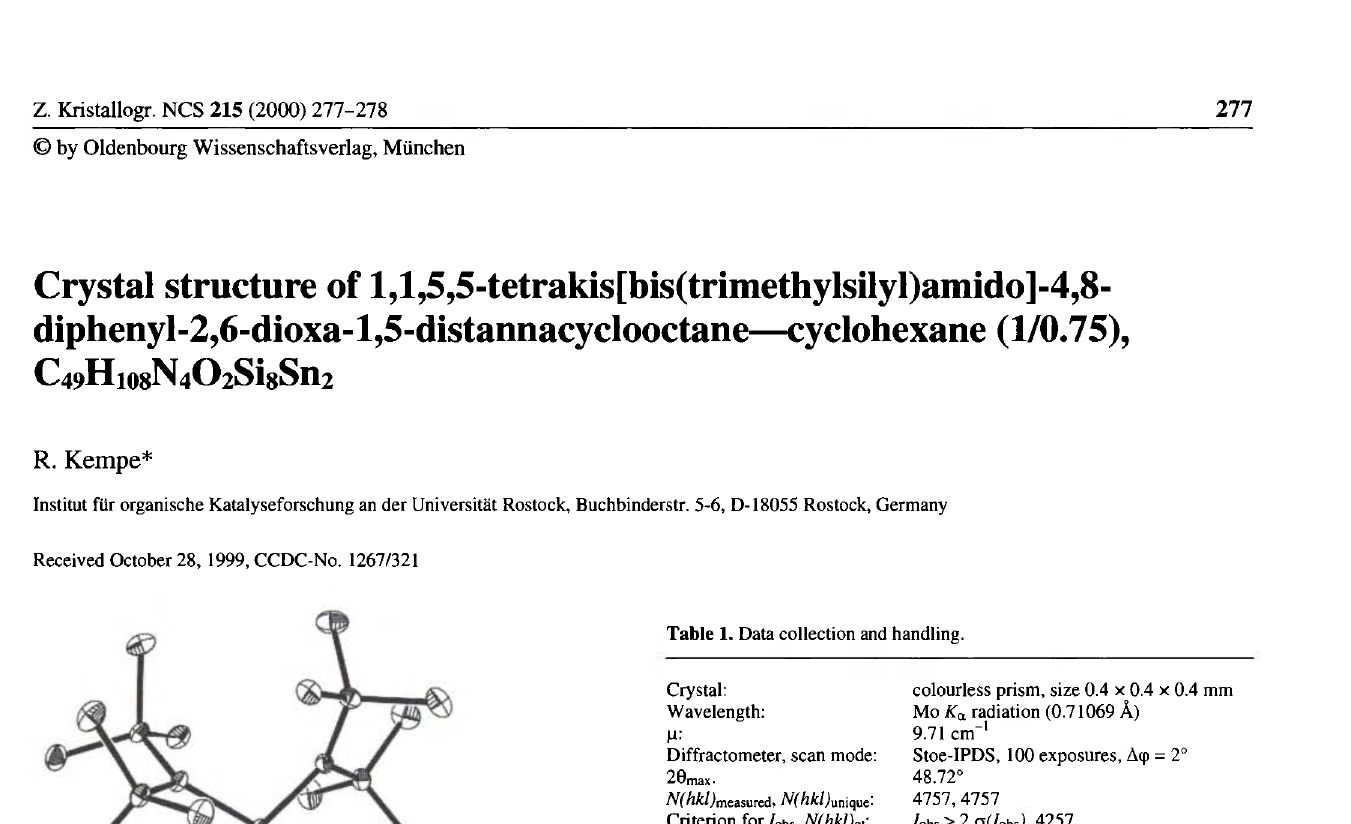
Table 2. Atomic coordinates and displacement parameters (in A